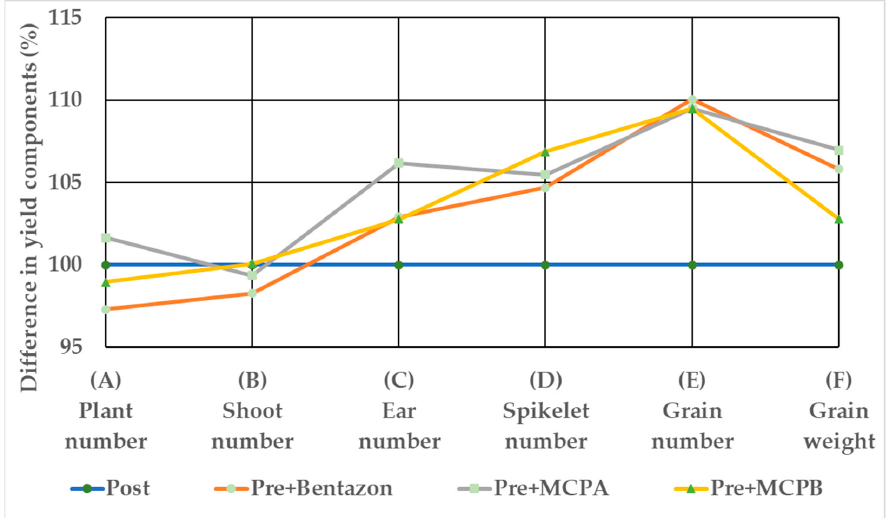
Figure 4. The effect of pre-emergence treatments on the development of winter wheat ( Triticum aestivum L.) in post-emergence treatments at tillering, over an average of 2 years.